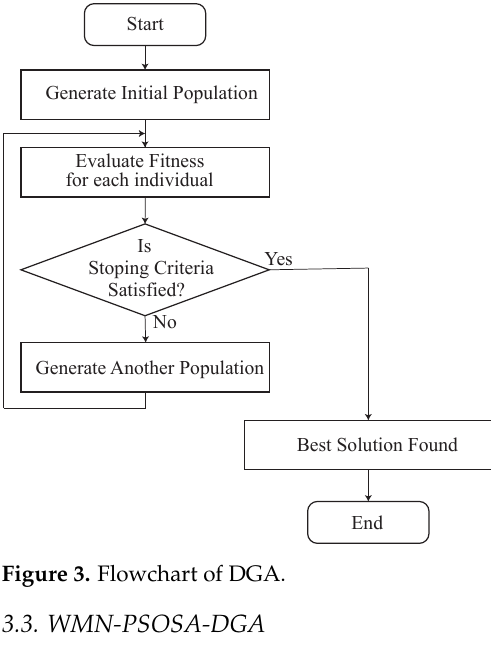
Figure 3. Flowchart of